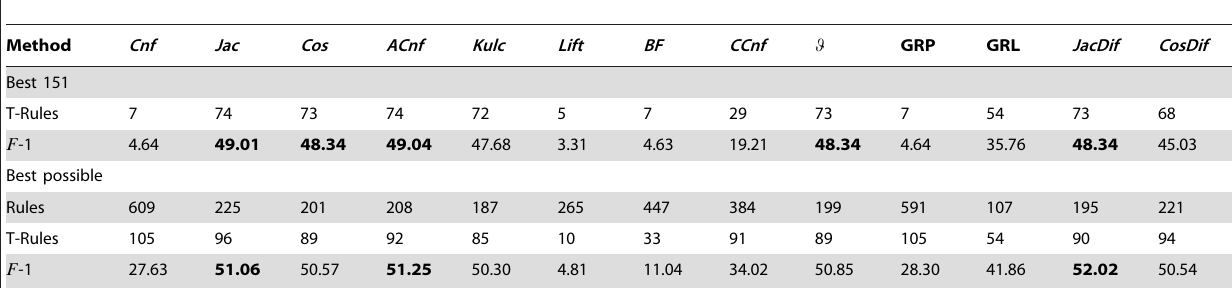
Table 4. DBpedia-Yago performance